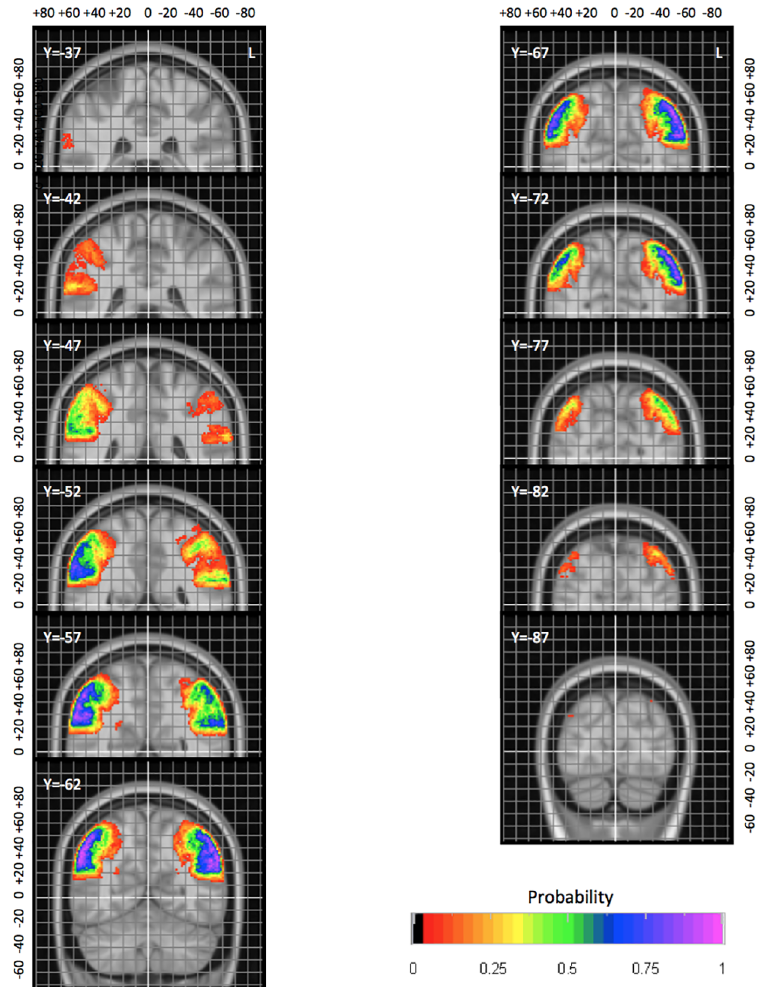
Fig 4. Example of a more detailed probabilistic map. AG in coronal orientationwith 5 mm spacing betweenslices. The position of the MNI space origin near the anterior commissure is highlighted in white. The grey grid is spaced by five millimetres. Coordinates are in millimetres in MNI space relativeto the origin. L, left.